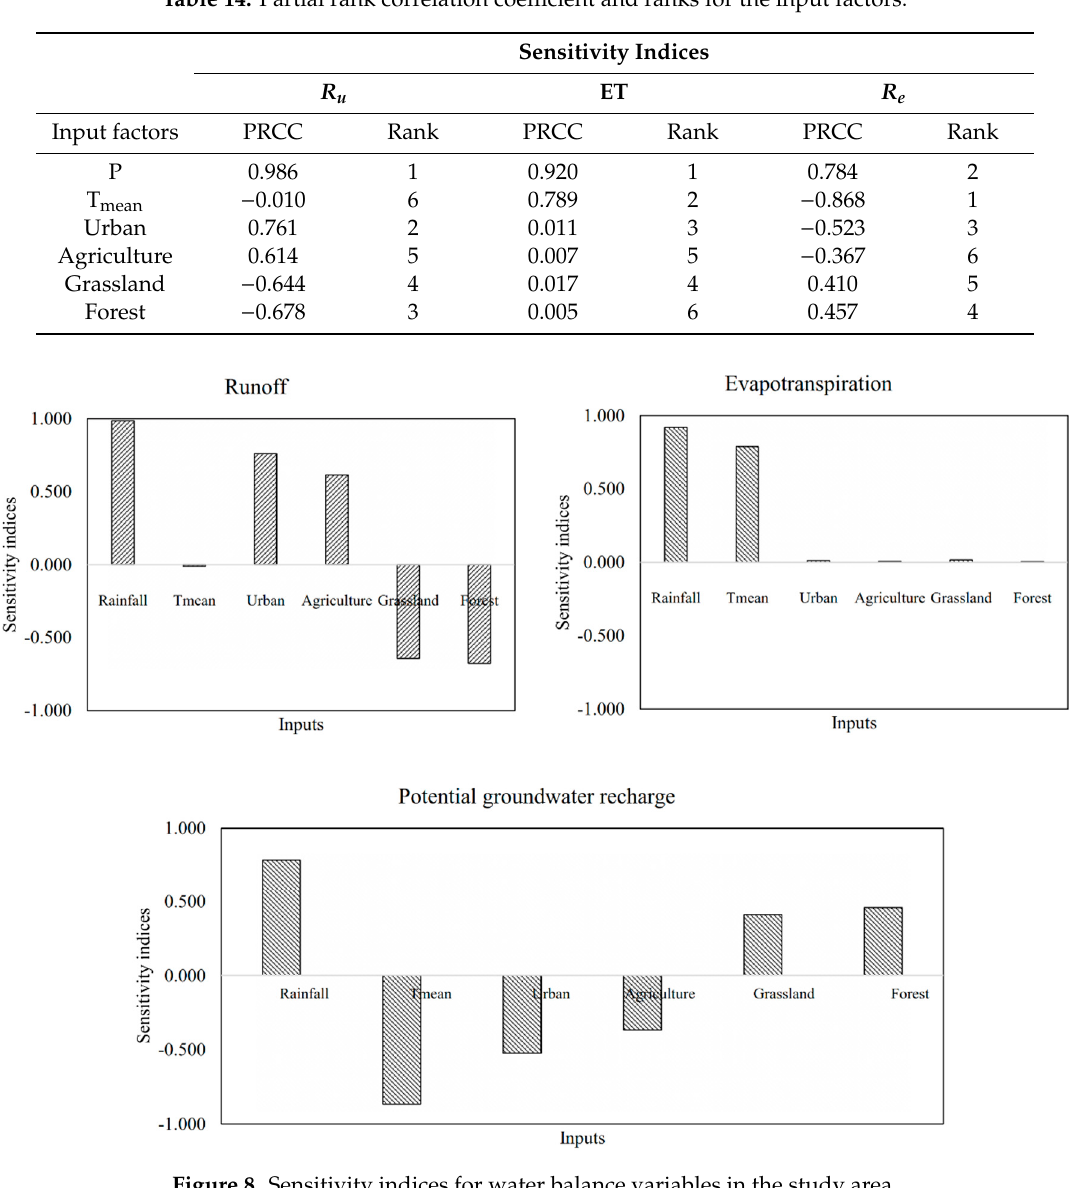
Figure 8. Sensitivity indices for water balance variables in the study area